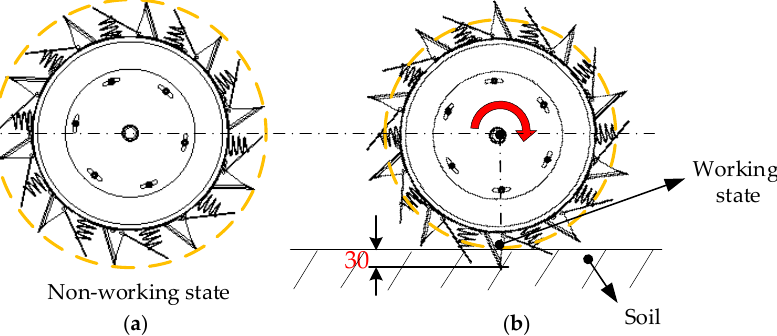
Figure 2. Schematic diagram of the duckbill non-working state and working state outer circle. ( a ) Schematic diagram of the duckbill non-working state outer circle; ( b ) Schematic diagram of the duckbill working state outer circle.